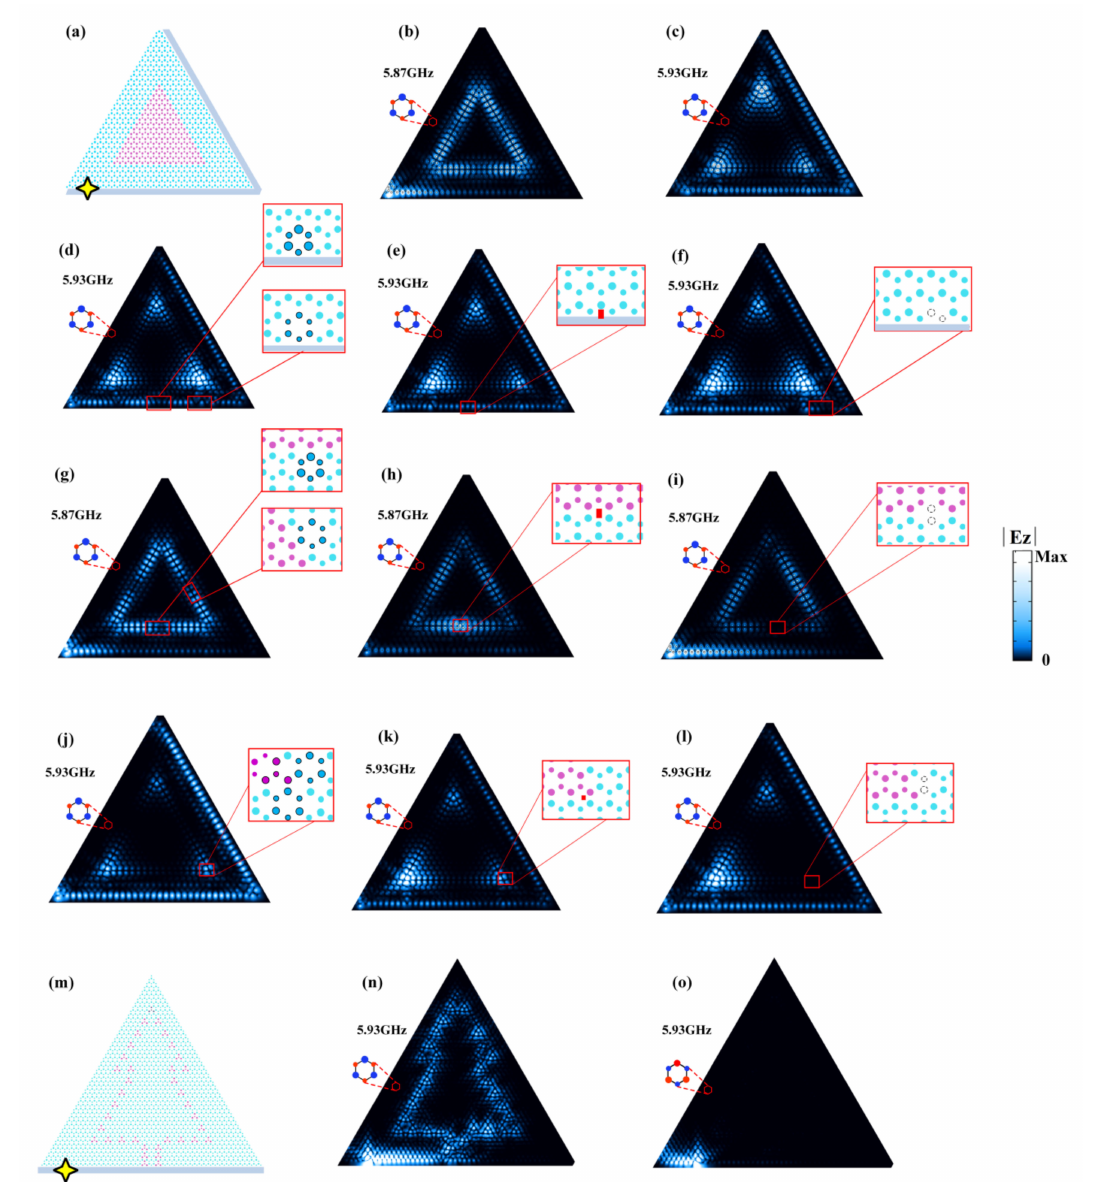
Figure 3. A multiplexing waveguide-resonator device and a tunable pine tree imaging with E 4 -edges as control ports. ( a ) Schematic of a triangular whisper-gallery ring composed of PC2 enclosed by PC1 and attached to an E 4 edge port. The excitation is employed at the left port-entrance, as indicated by the yellow star. Numerically simulated electric field distributions of the waveguide-resonator in ( a ) at the exciting frequencies of ( b ) 5.87 GHz and ( c ) 5.93 GHz are presented. The insets depict the magnetic bias (with red color indicating the positive magnetic field and the blue color indicating the negative magnetic field). ( d – l ) Robustness study for the three types of topological states including ( d – f ) the anti-chiral edge states induced by breaking the time-reversal symmetry, ( g – i ) the valley-dependent edge states induced by breaking the inversion symmetry and ( j – l ) the corner states induced by breaking the inversion symmetry. Three types of perturbations are deliberately introduced, which are, successively from left to right, the C 3 v -preserving expanded/shrunken unit cells (highlighted by darker colors and solid circles), inserted dielectric obstructions (indicated by the red blocks), and the C 3 v -breaking removed PC rods (whose locations are indicated by the dotted circles). The expanding/shrinking strength in ( d , g ) is 10% while that in ( j ) is 5%. The dielectric constant for the obstructions is 12 while their geometric sizes are 0.24 a × 0.6 a for ( e ) and ( h ) and 0.18 a × 0.4 a for ( k